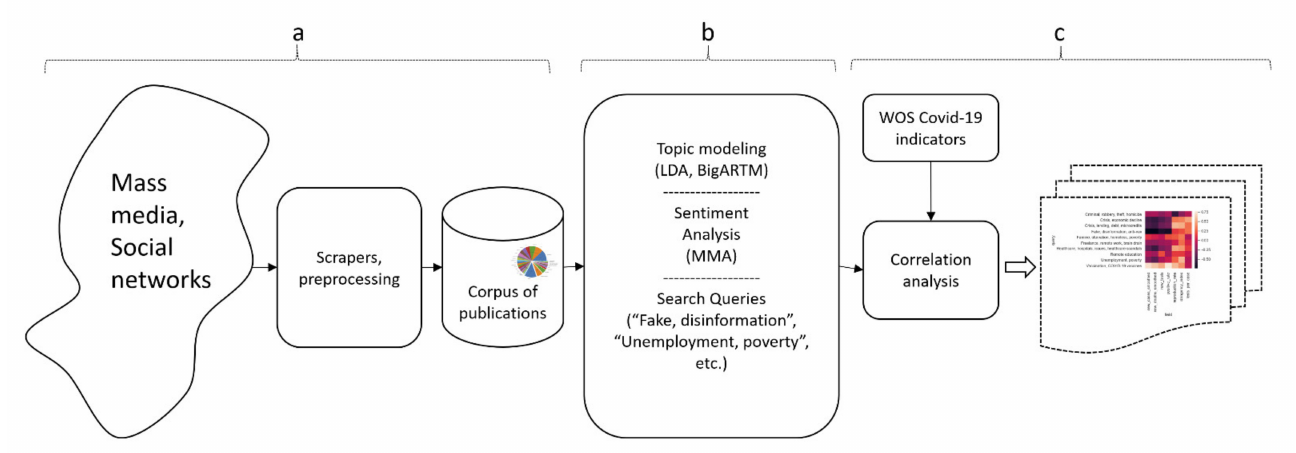
Figure 1. Main steps of the method for correlation analysis of mass media indicators and COVID-19